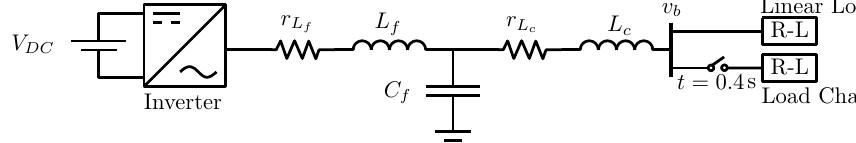
Figure 12. The first case study.